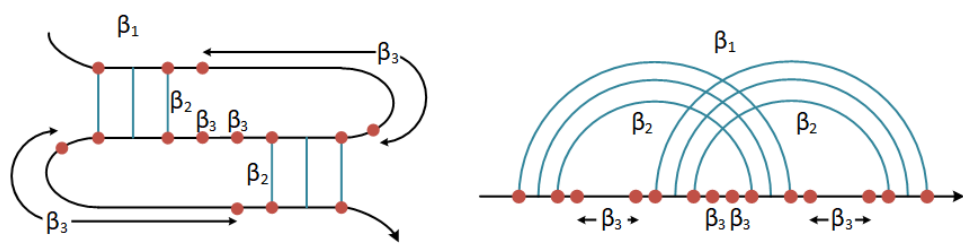
Figure 6. The cost of forming a pseudoknot is β 1 , while core stems contribute a cost β 2 and unpaired bases inside the pseudoknot a cost β 3 . The energies associated with the stacked base pairs were computed with respect to the standard model [87] (after